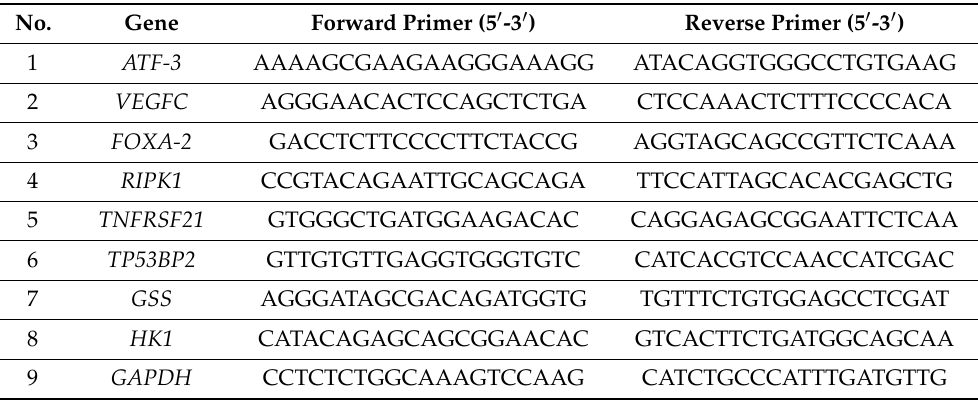
Table 2. Primer sets used for RT-PCR